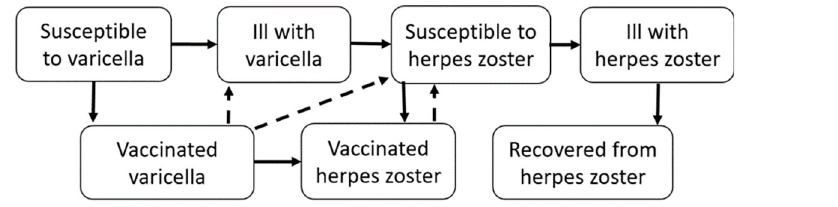
Fig 1. Simplified flowchart of the epidemiological